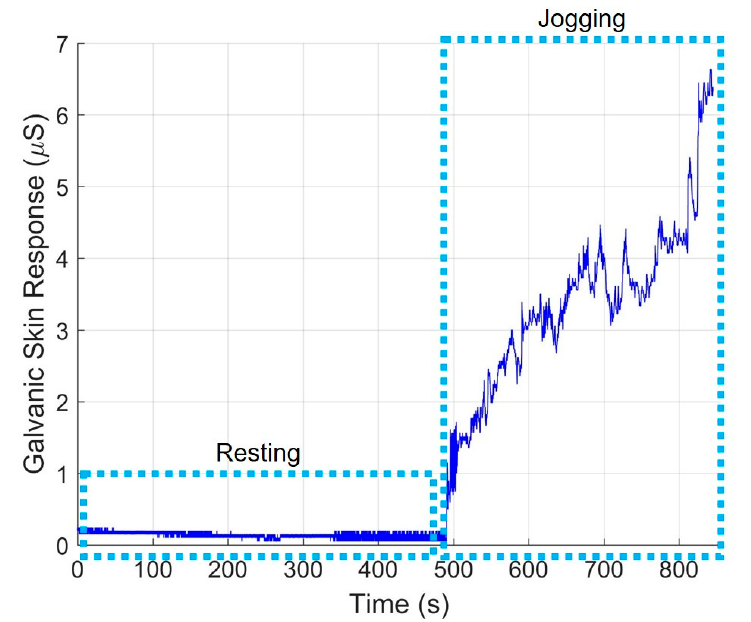
Figure 7. Representative galvanic skin response shows an increase in skin conductance as a result of perspiration during a jogging